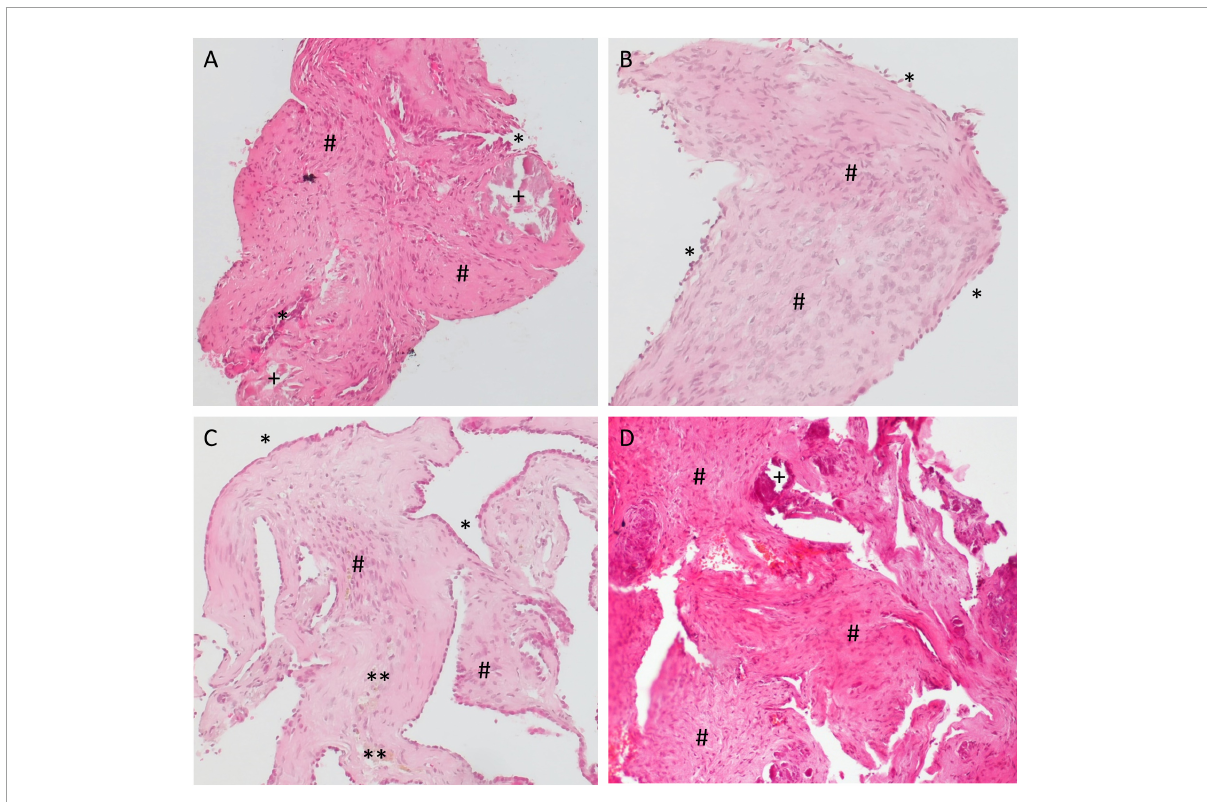
FIGURE6 Histology examination of specimens taken from the RW area of different patients at the time of cochlear implantation. (A,B) 16 months; (C) 6 months, and (D) 18 months after implantation of the biodegradable drug delivery system and sealing with soft tissue. Hematoxylin-eosin (H&E), 100x. Histomorphology was comparable between patients. Particles of collagenous fibers with a moderate cellularity were covered on the surface with one layer of a monomorphic flat to cuboid epithelium ( ∗ ). The stroma contained areas of resting, as well as of proliferating fibroblasts (#) and some macrophages ( ∗∗ ). There was no substantial inflammation. In some specimen, we found scattered, medium sized amorphous calcifications ( + ) within the stroma that did not react to polarized